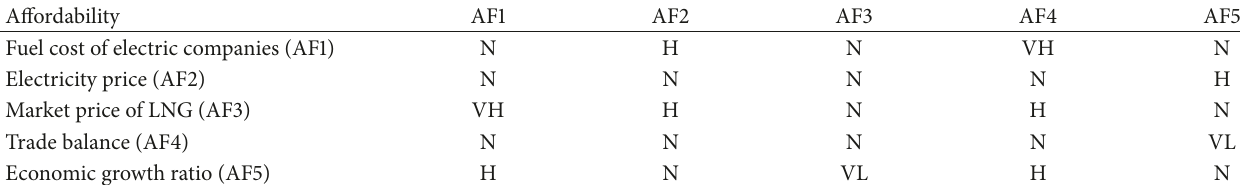
Table 8: Direct-influenced relation matrix using linguistic values for Affordability (Case 2 ).